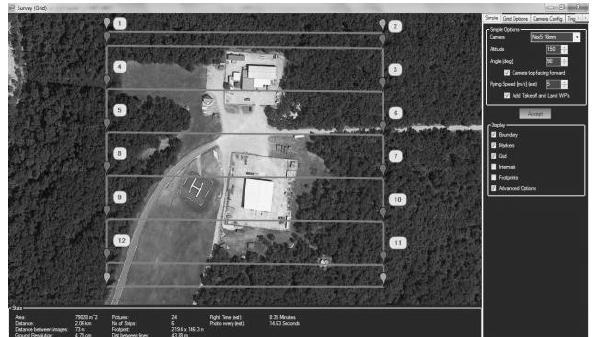
Figure 1. Mission Planner survey tool plots flight lines base on mission constraints using ©2014 Google Earth image Camera trigger options can be programmed from the autopilot via electrical impulse, IR strobe or mechanical servo. The autopilot will log the time, position and orientation of the camera, which is very useful for 3D